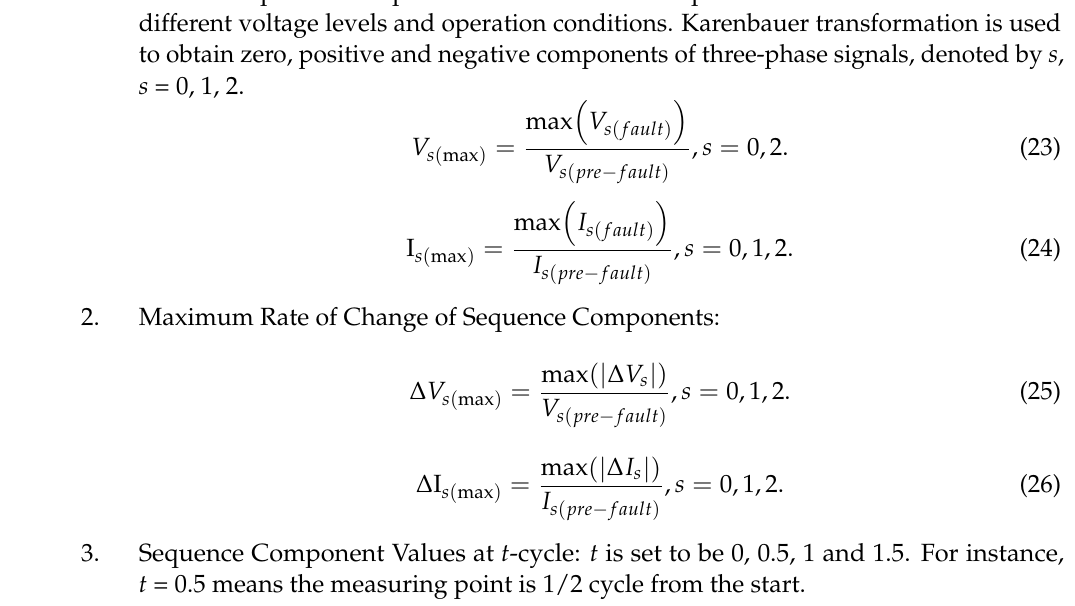
Maximum Change of Sequence Components: Instantaneous magnitude is calculated relative to prefault amplitude in order to be compatible with measurements from different voltage levels and operation conditions. Karenbauer transformation is used to obtain zero, positive and negative components of three-phase signals, denoted by s , s = 0, 1, 2.